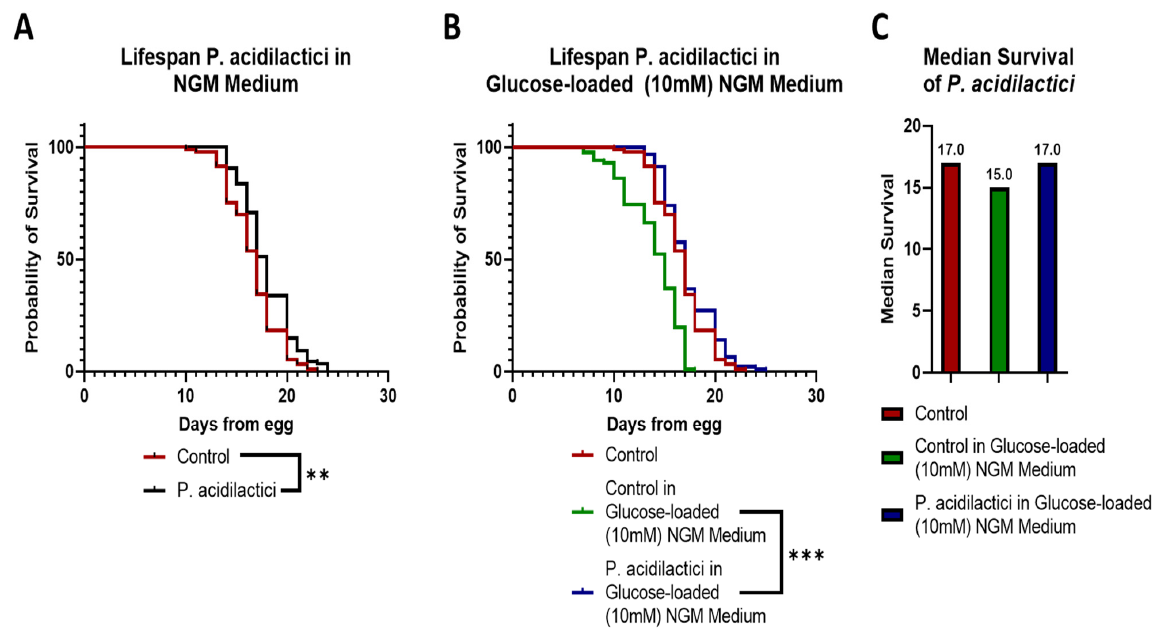
Figure 6. Pediococcus acidilactici increases lifespan of C. elegans ( A ) Lifespan analyses of water- and pA1c-treated worms in a NGM medium. Significance refers to the effect of pA1c with respect to control worms in a NGM medium (log-rank Mantel-Cox Test, ** p < 0.01). ( B ) Lifespan analyses of water- and pA1c-treated worms in a glucose-loaded (10mM) NGM medium. Significance refers to the effect of pA1c with respect to control worms in a glucose-loaded (10mM) NGM medium (log-rank Mantel-Cox Test, *** p < 0.001). ( C ) Median survival (in days) of control worms in a NGM medium and in a glucose-loaded (10mM) NGM medium, and of pA1c-treated worms in a glucose-loaded (10mM) NGM medium.